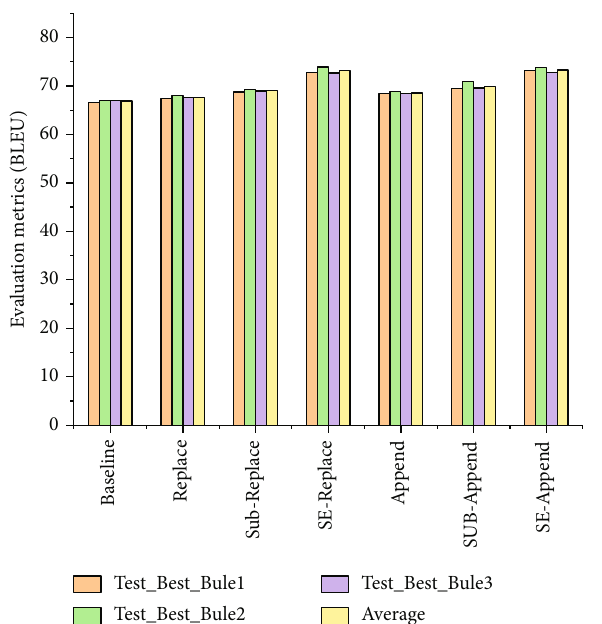
Figure 4: Test set translation performance.